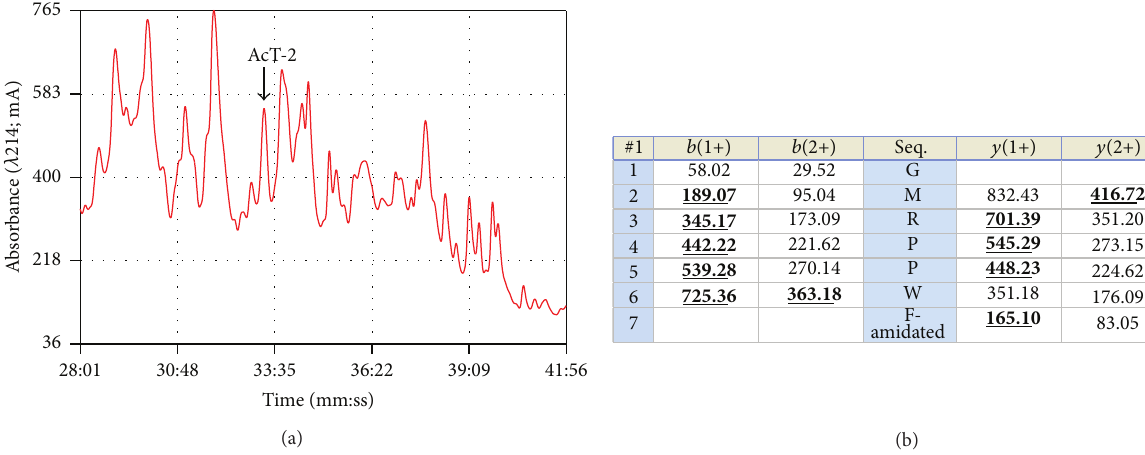
Figure 1: Region of reverse phase HPLC chromatogram of Agalychnis callidryas skin secretion indicating the elution position/retention time (arrow) of absorbance peak containing the peptide, AcT-2 (a). Expected singly and doubly charged b- ion and y- ions arising from fragmentation of AcT-2 as predicted using the MS-Product program available through Protein Prospector online. Observed fragment ions are indicated in bold type face and are underlined